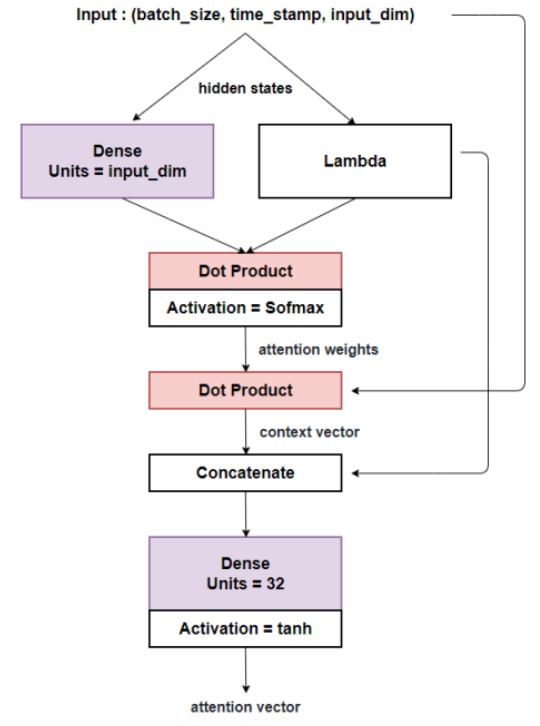
Figure 8. Structure of hierarchical attention network [26]. The attentions were implemented twice consequently. The first attention is implemented with a fully connected layer and a lambda function, and the second attention was implemented with the input vector and the output of the first attention. The output of the second attention was concatenated with the output of the lambda function, which becomes the input of the fully connected layer to generate the output of the attention network. With the proposed base model, the Siamese network receives two input data as a factor. Each input is passed through the base model to obtain a pair of embedding vectors. The similarity is obtained by applying a sigmoid function to the distance between the two vectors. The distance is calculated using the L1 distance layer. 2.5. Train and Test Batch The Siamese network compares two input data and determines whether they belong to the same group (matched) or in different groups (unmatched). The network was trained or tested batch by batch, with a batch comprising 40 characters (Figure 9). A batch is a set of pairs of eye-written characters. Half of the batches were matched pairs, and the others were unmatched pairs. The target values of the batch were a vector with a length of 20. The first half of the vectors had a value of 0, and the left half had a value of 1. The network learnt to estimate the similarity between data pairs.